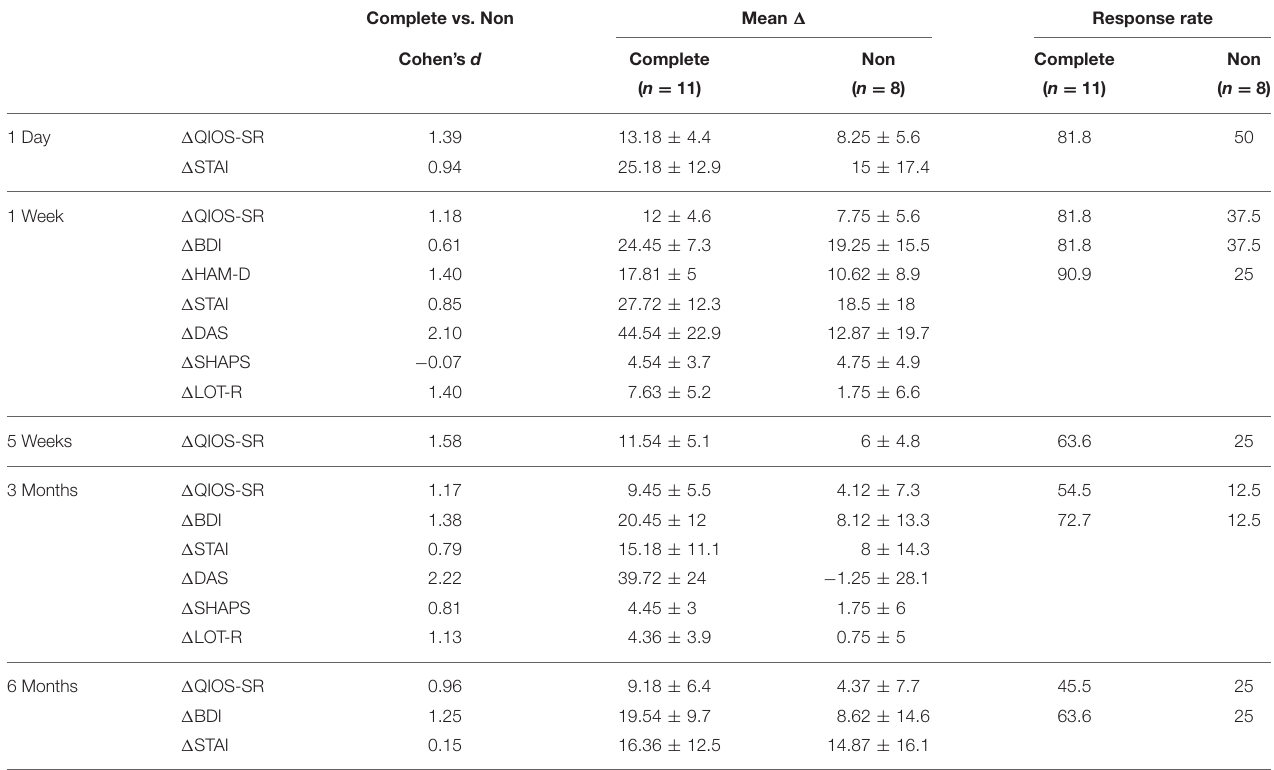
TABLE 2 | Comparisons of “complete” OBN ( n = 11) and “non-complete” ( n = 8) with different clinical measures in different time points. Complete vs. Non Mean 1 Response rate Cohen’s d Complete